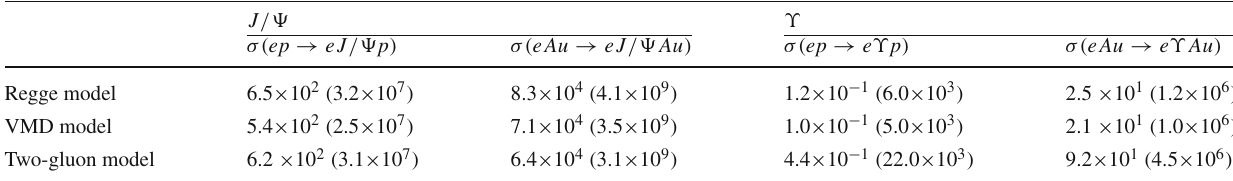
considering different models for the γ p → V p cross section. The inte- grated luminosity per year is assumed to be 50 fb − √ s = 16 . 7 GeV and